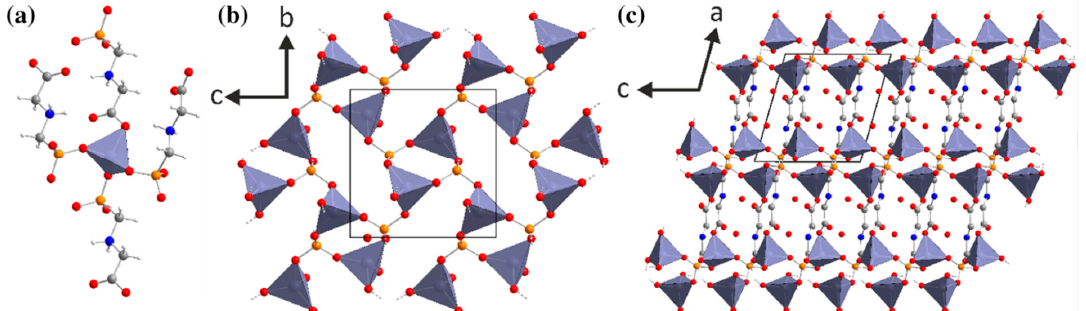
Figure 11. Structure of Zn(O 3 PCH 2 NH 2 CH 2 CO 2 )·H 2 O. ( a ) Coordination sphere of the Zn 2+ ion. ( b ) Structure of the layer formed by the ZnO 4 -tetrahedra and the phosphono groups, shown along the a -axis. ( c ) Pillared structure of the framework shown along the b -axis (c). Hydrogen atoms are omitted for clarity. Colour code: Purple: zinc, red: oxygen, orange: phosphorus, blue: nitrogen, grey: carbon, and white: hydrogen. Adapted with permission from reference. [58]. Copyright 2017, Springer Science Business Media.